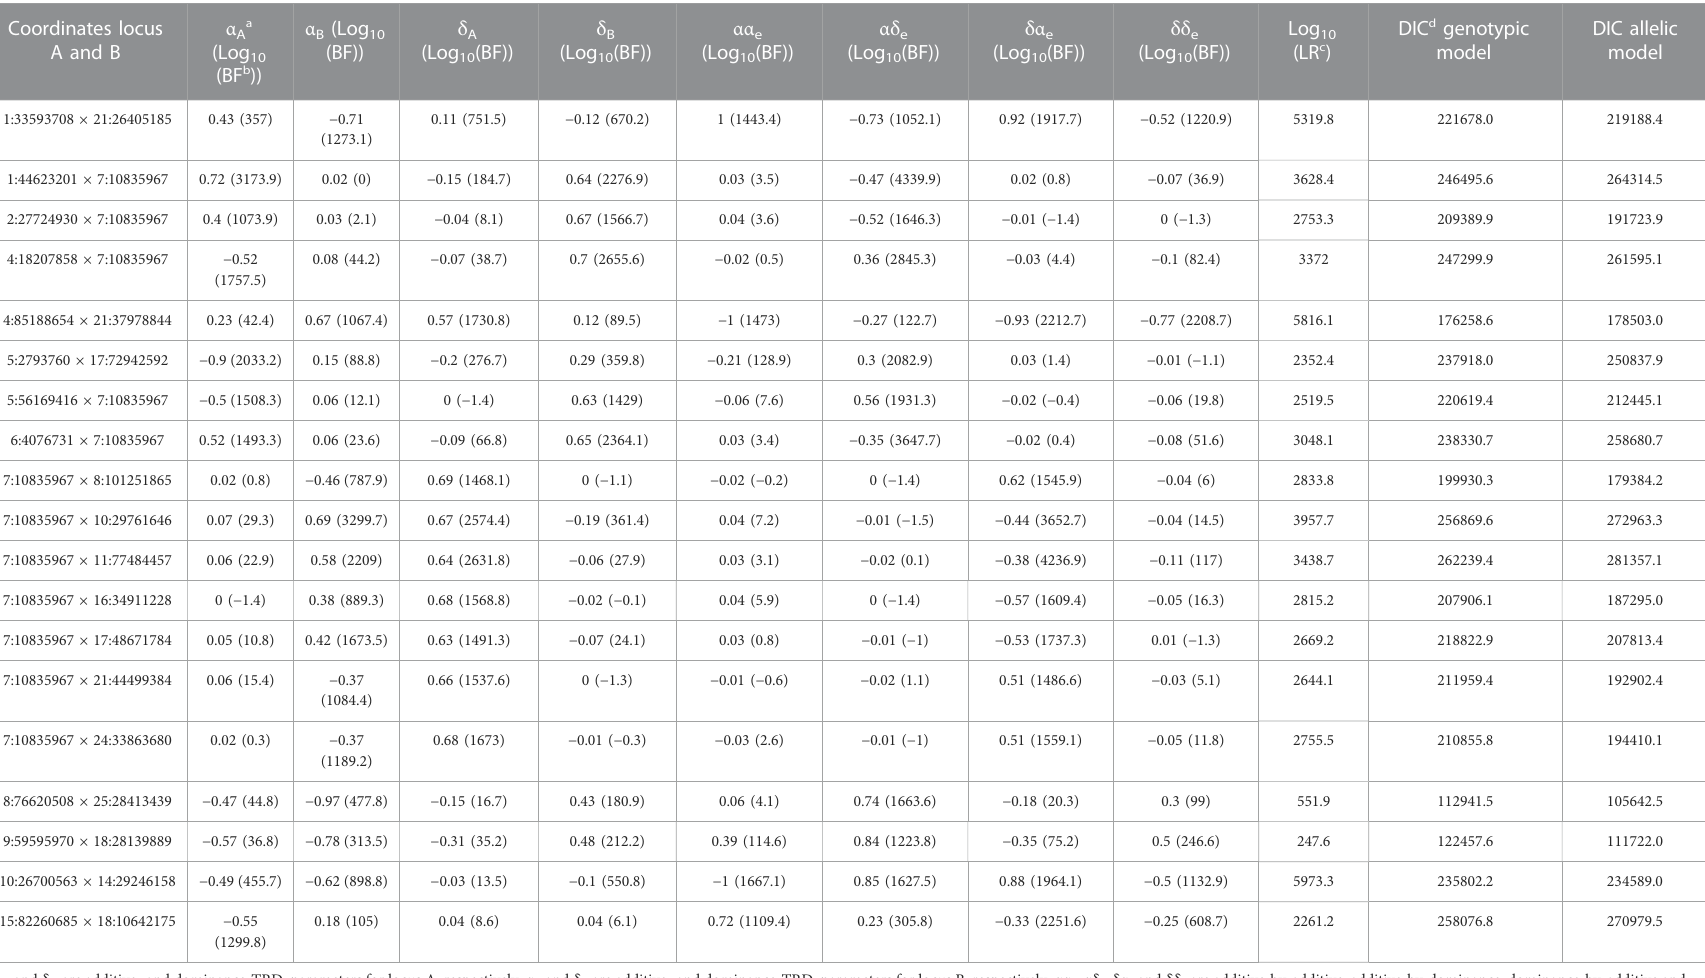
TABLE 2 Pairs of genomic regions identi fi ed with epistatic transmission ratio distortion (TRD) in Holstein cattle with mainly additive-by-dominance effects. Coordinates locus A and